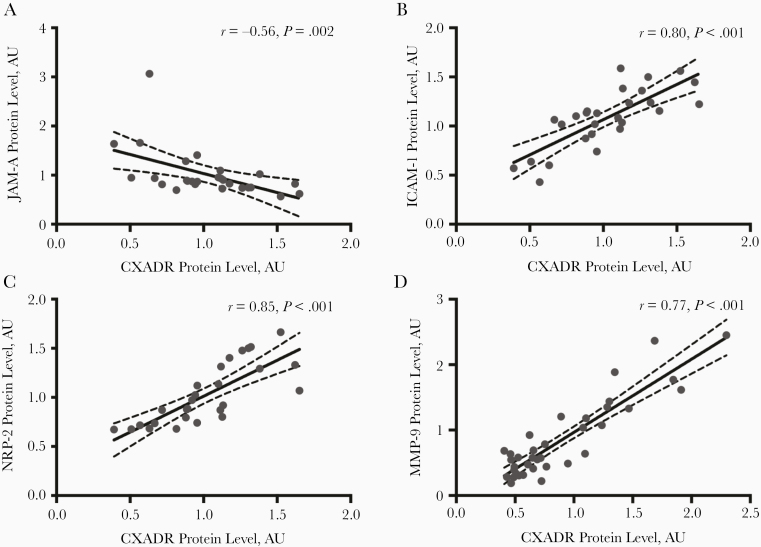
Proteomic analysis of the levels of coxsackievirus and adenovirus receptor (CXADR) and other virus receptors in human carotid plaques. A–D, Pearson correlation between CXADR and junction adhesion molecule A (JAM-A) (A), inflammatory cell adhesion molecule 1 (ICAM-1) (B), neuropilin 2 (NRP2) (C), and matrix metalloproteinase 9 (MMP-9) (D) protein levels in human plaques. Abbreviation: AU, arbitrary units.